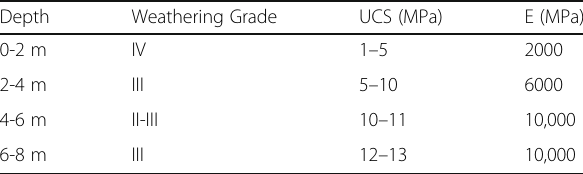
Table 2 The geotechnical properties of the intact rock samples with depth (KV5)